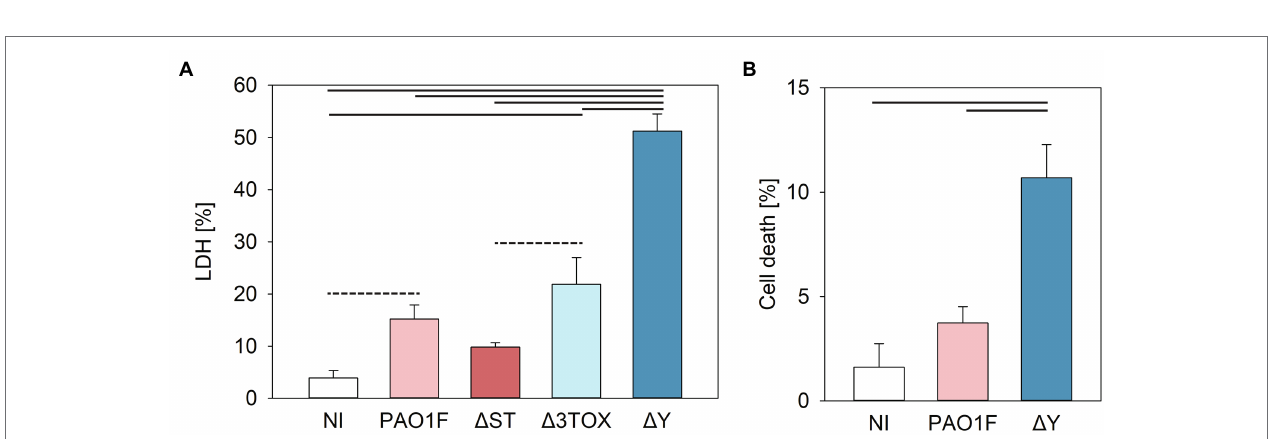
FIGURE 5 | Cytotoxicity measured by lactate dehydrogenase (LDH) release (A) or fluorochrome 7-amino actinomycin D (7-AAD) detection of cell damage (B) in human bronchial NCI-H292 cells infected by P. aeruginosa strains for 3 h at MOI 20. (A) Cytotoxicity was assessed based on the amount LDH released by epithelial cells into the culture supernatant measured as detailed in the Materials and Methods (determined as % of total cell LDH). Mean values and SD were calculated from three independent measurements taken using the CytoTox 96 ® Non-Radioactive Cytotoxicity Assay kit. One way ANOVA analysis with subsequent pairwise comparison (Turkey method) revealed significant differences between pairs connected by solid lines or dashed lines indicating value of p < 0.001 or < 0.005, respectively. (B) 7-AAD-mediated detection of cell damage. Cells were stained with 7-AAD as described in Materials and Methods and analyzed with a cytoFLEX Beckman Coulter Flow Cytometer and FlowJo software. Mean values and SD correspond to three independent experiments with samples measured in duplicate. Experiments were performed on NCI-H292 that had undergone between 8 and 20 passages. Pseudomonas aeruginosa strains expressed the following T3SS effectors: PAO1F, wild-type expressed ExoS, ExoT, and ExoY; Δ ST expressed only ExoY; Δ 3TOX , expressed none of the T3SS effectors; and Δ Y expressed ExoS and ExoT. One way ANOVA analysis revealed significant differences ( p < 0.001) between PAO1F and Δ Y .